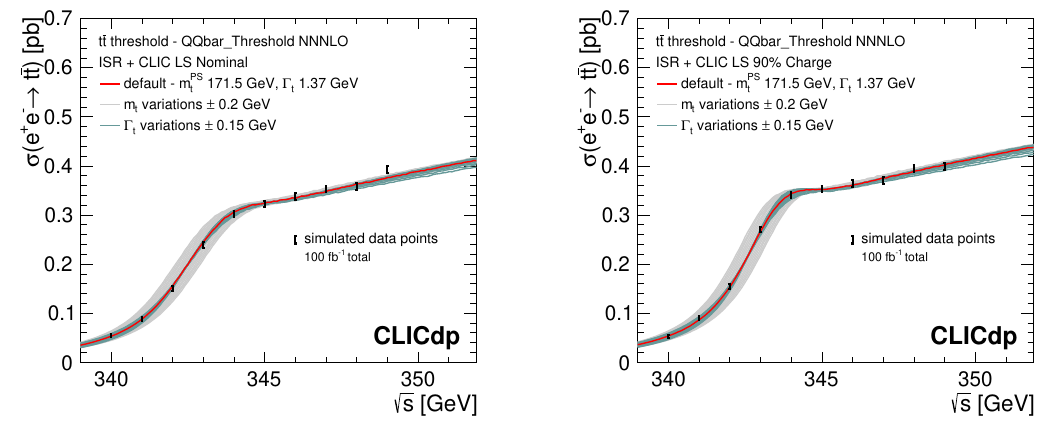
Figure 10. Illustration of a top-quark threshold scan at CLIC with a total integrated luminosity of 100 fb (cid:0) 1 , for two scenarios for the luminosity spectrum, nominal (left) and ‘reduced charge’ (right). The bands around the central cross section curve show the dependence of the cross section on the top-quark mass and width, illustrating the sensitivity of the threshold scan. The error bars on the simulated data points show the statistical uncertainties of the cross section measurement, taking into account signal e(cid:14)ciencies and background